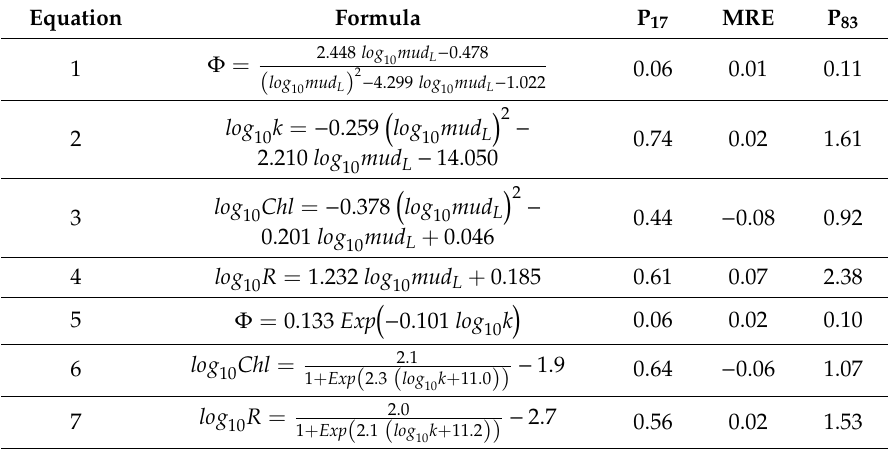
Table 2. Compiled regression equations. The distributions of the relative errors are indicated as the 17th percentile (P 17 ), median of relative errors (MRE), and 83th percentile (P 83 ). Please refer to Appendix A for abbreviations and